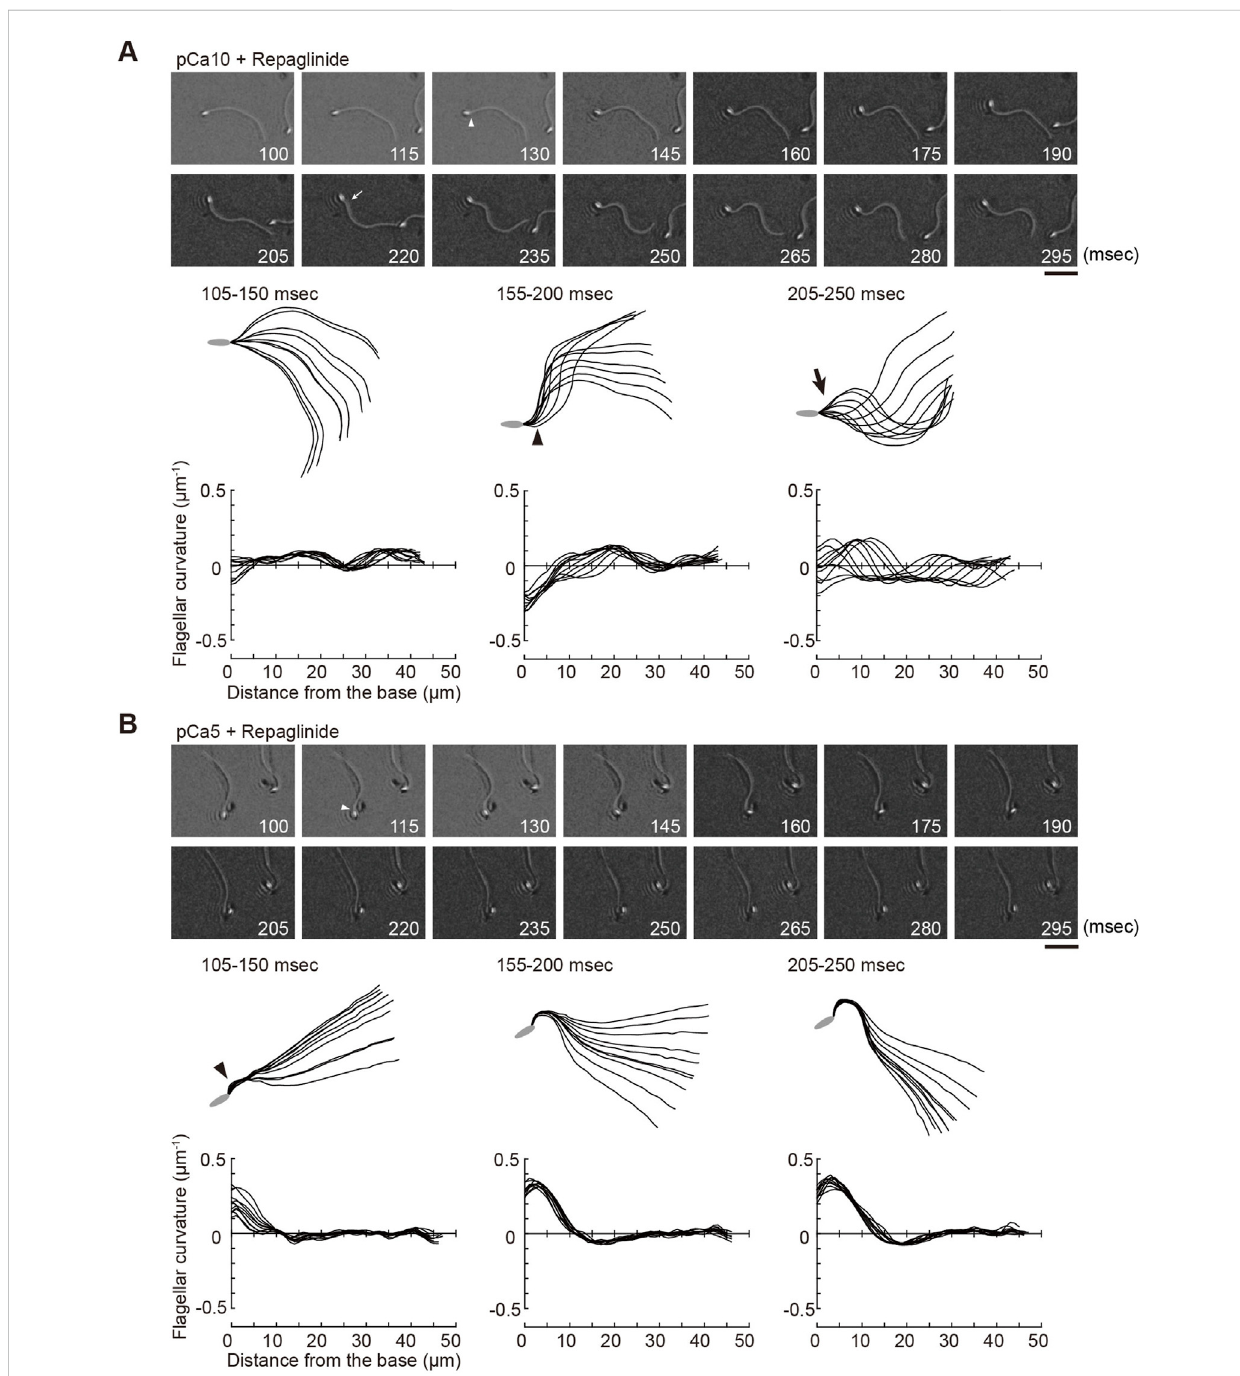
FIGURE 3 Effect of a calaxin inhibitor on the formation and propagation of asymmetry waveforms induced by photolytic release of caged ATP at high calcium concentrations. Sperm cells were demembranated and incubated in the reactivation solution with caged ATP at low (pCa10; (A) ) or high (pCa5; (B) ) Ca 2+ concentrationswith150 μ Mrepaglinide.ReleaseofATPwastriggeredbyUV fl ash.Upperpanel:sequentialimagesofsperm fl agellarwaveformsat15 ms- intervals from 100 ms after the UV fl ash. Arrow heads and arrows indicate the initial bend and the second bend, respectively. Scale bar, 20 μ m. Middle panel: overwritten images of demembranated sperm at 5 ms intervals during the periods of time (105 – 250 ms) after release of ATP. Arrow heads and arrows indicate the initial bend and the second bend, respectively. Lower panel: changes of fl agellar curvature occurring 105 – 250 ms after the UV fl ashareplottedagainstthedistancefromthebaseof fl agellum.Tenwaveformsproducedat50 msareoverwritten.Onetypicalspermexamplefromthe all experiments at least three times with three different specimens was shown.